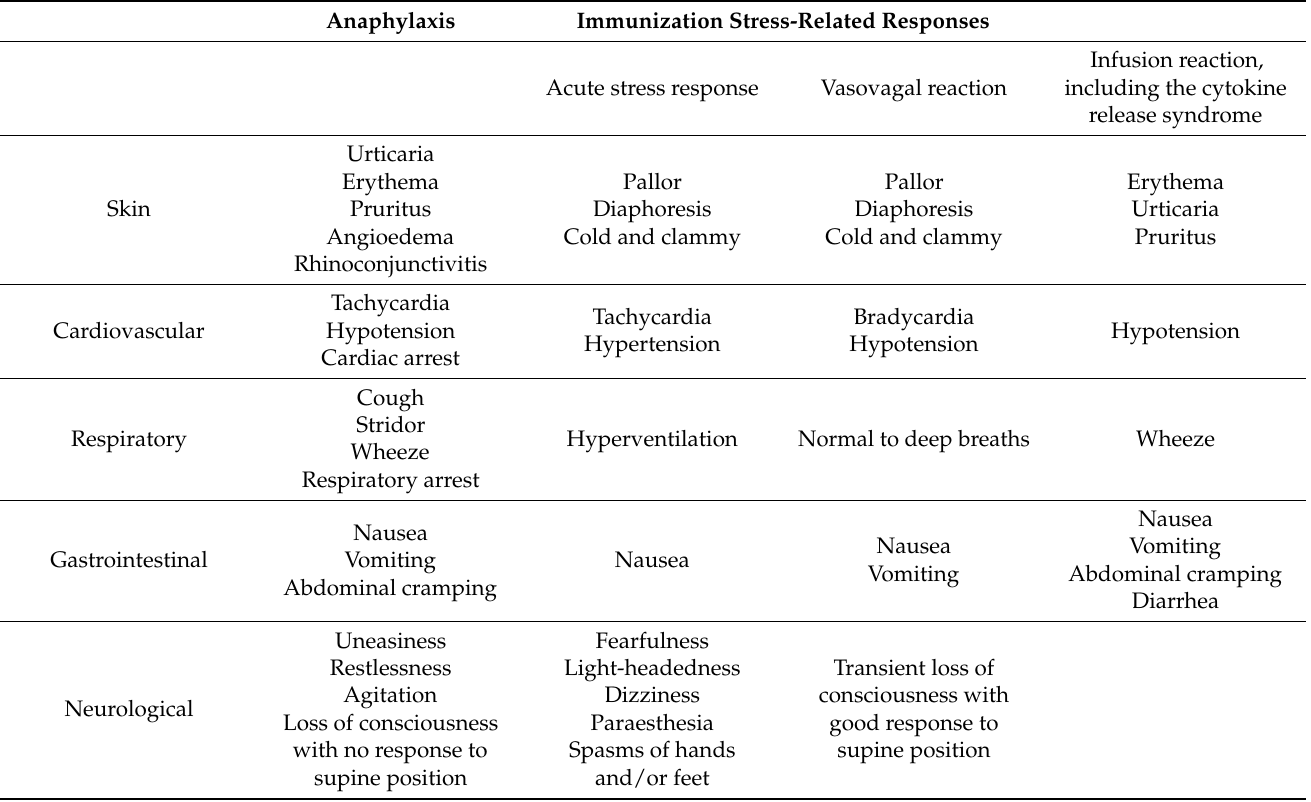
Table 1. Symptoms of anaphylaxis, immunization stress-related responses, and infusion